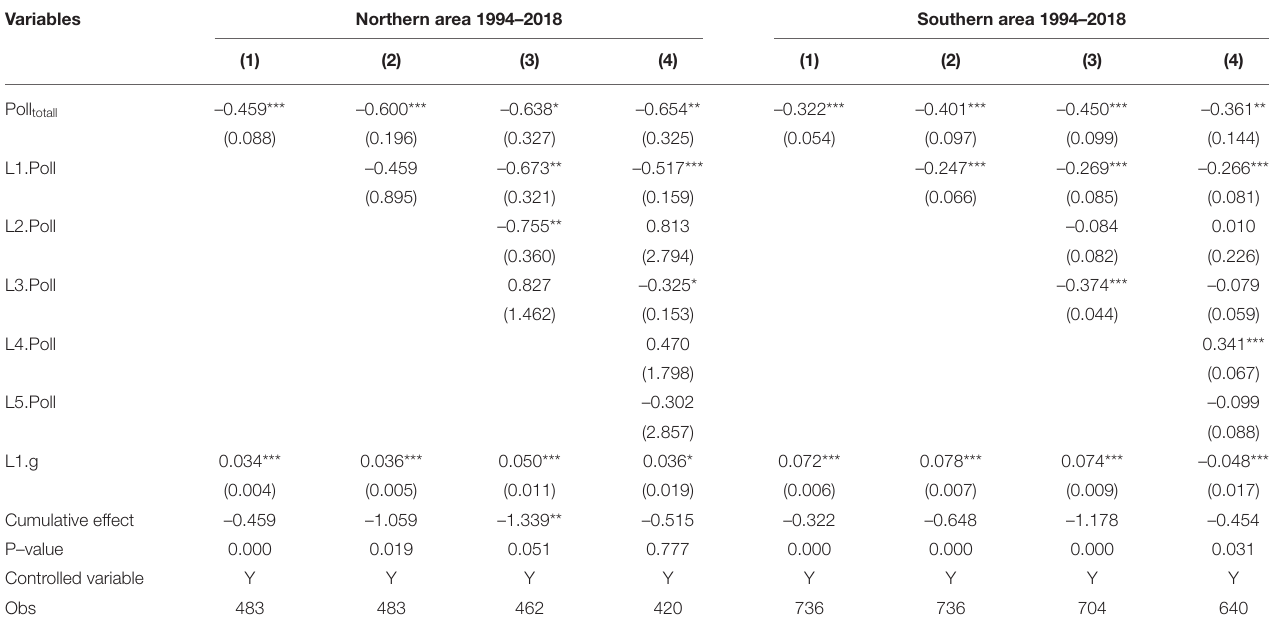
TABLE 9 | Estimated results by